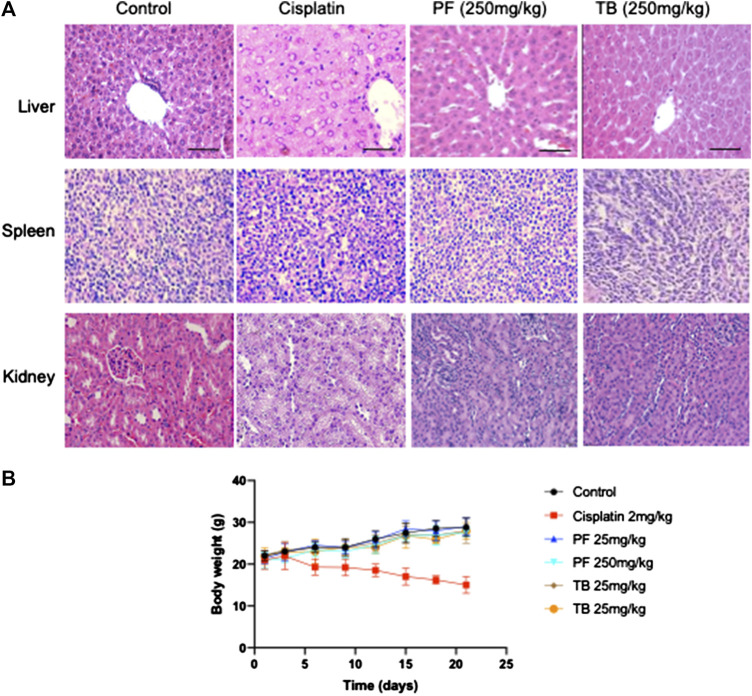
Toxicity assay of PF and TB in nu/nu female mice. (A): representative slides of H&E statining of different organs including liver, spleen and kidney. (B): time-course of body weight in different groups. Group 1: control (PBS, i.p.); group 2: cisplatin (2 mg/kg, i.p.); group 3: PF (25 mg/kg, i.p.); group 4: PF (250 mg/kg, i.p.); group 5: TB (25 mg/kg, i.p.); group 6: TB (250 mg/kg, i.p.). Bars: 50 µm, magnification ×20.